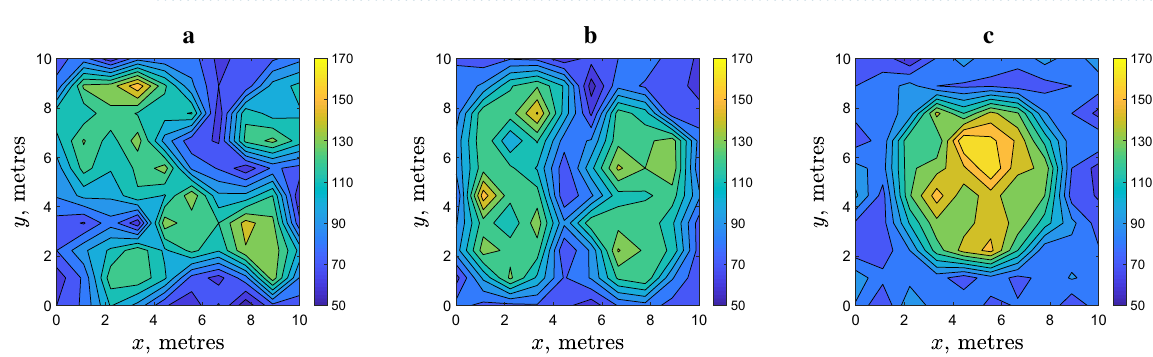
10 4 slugs at t 10, 000 simulated for different values of the threshold Figure 4. The spatial distribution of N = = 80 , ( b ) d 100 and ( c ) d 120 (slugs/m − 2 ). Other parameters are as in Fig. 2. density: ( a ) d = = =